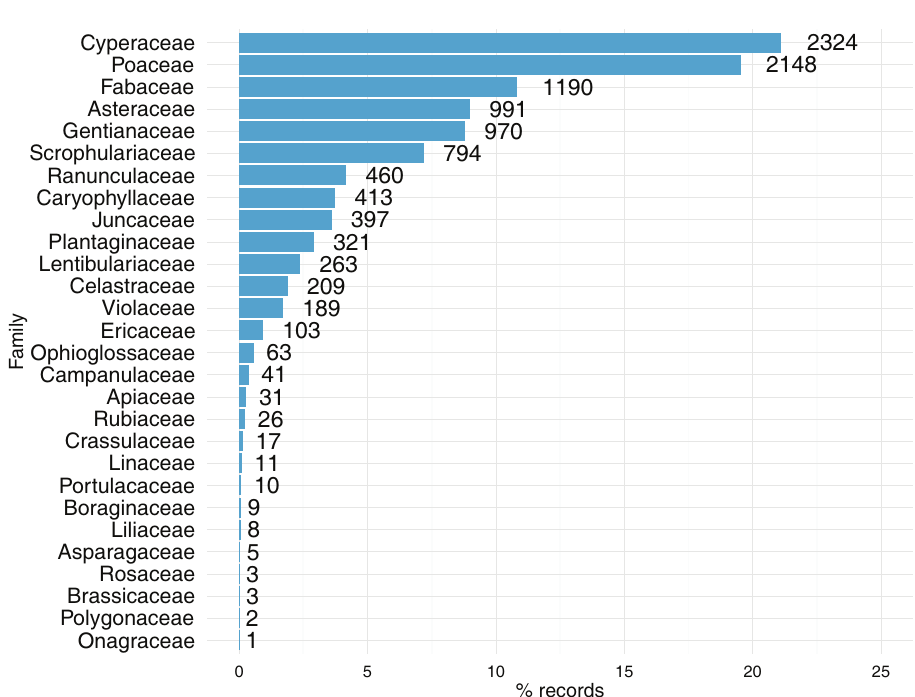
Figure 3. Taxonomic coverage (families). Percentage of dataset records by families. The numbers indicate the records of each